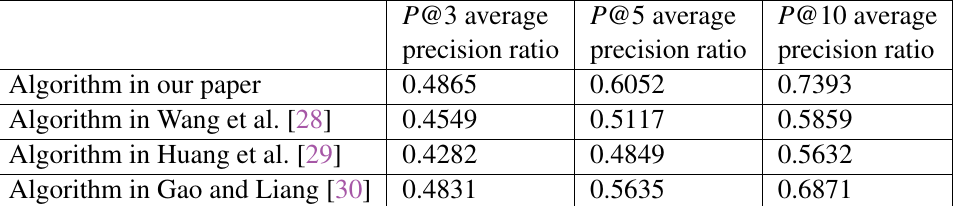
Table 3. The experiment results of ontology similarity